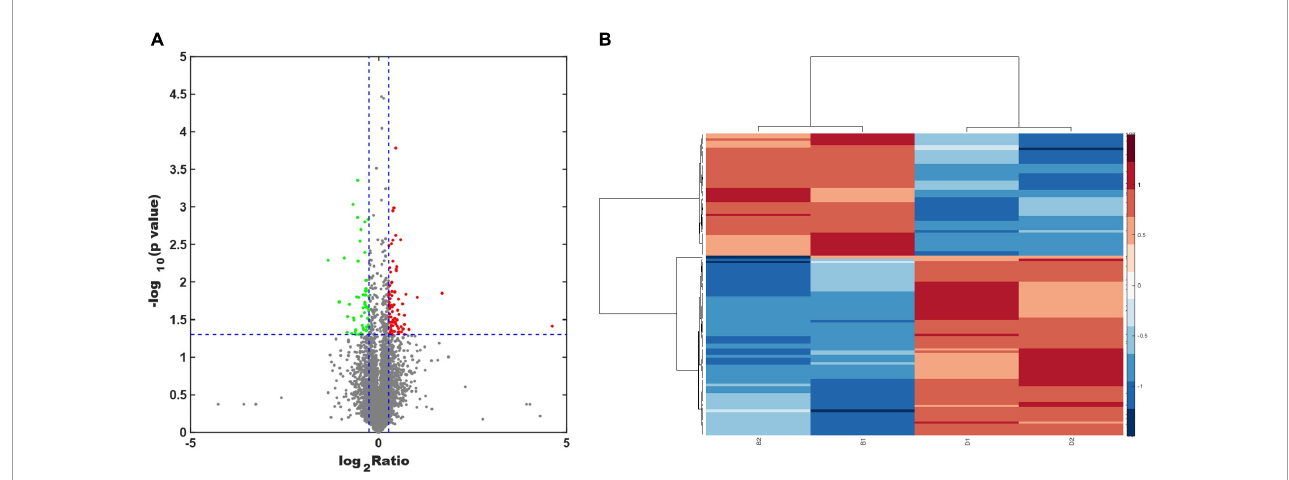
FIGURE3 (A) Volcano plot analysis of the differentially expressed proteins between the ASE treatment and the PD group. Proteins that have a difference of fold change > 1.2 or < − 1.2 and a P < 0.05 are defined as significantly different. The red points indicate proteins with a significant upregulation, while the green points indicate proteins with a significant downregulation. (B) Heatmap analysis of the differentially expressed proteins between the ASE treatment and the PD